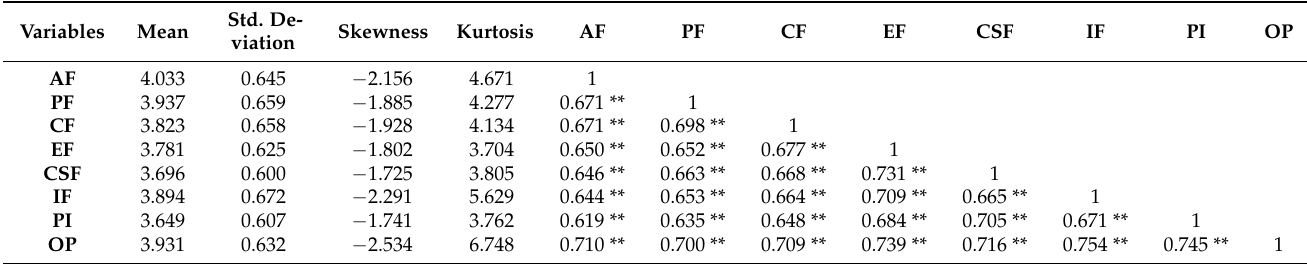
Table 2. Descriptive and Pearson Correlations